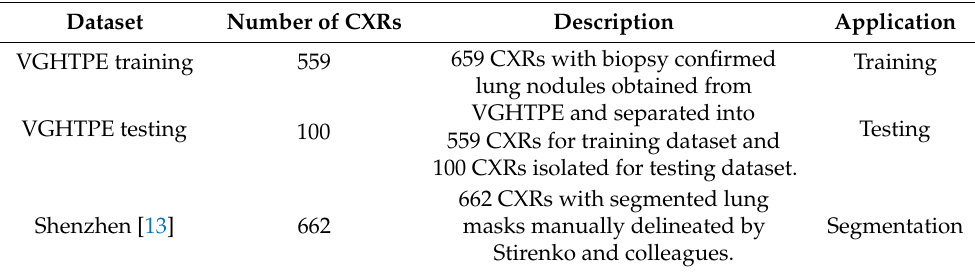
Table 1. Introduction of